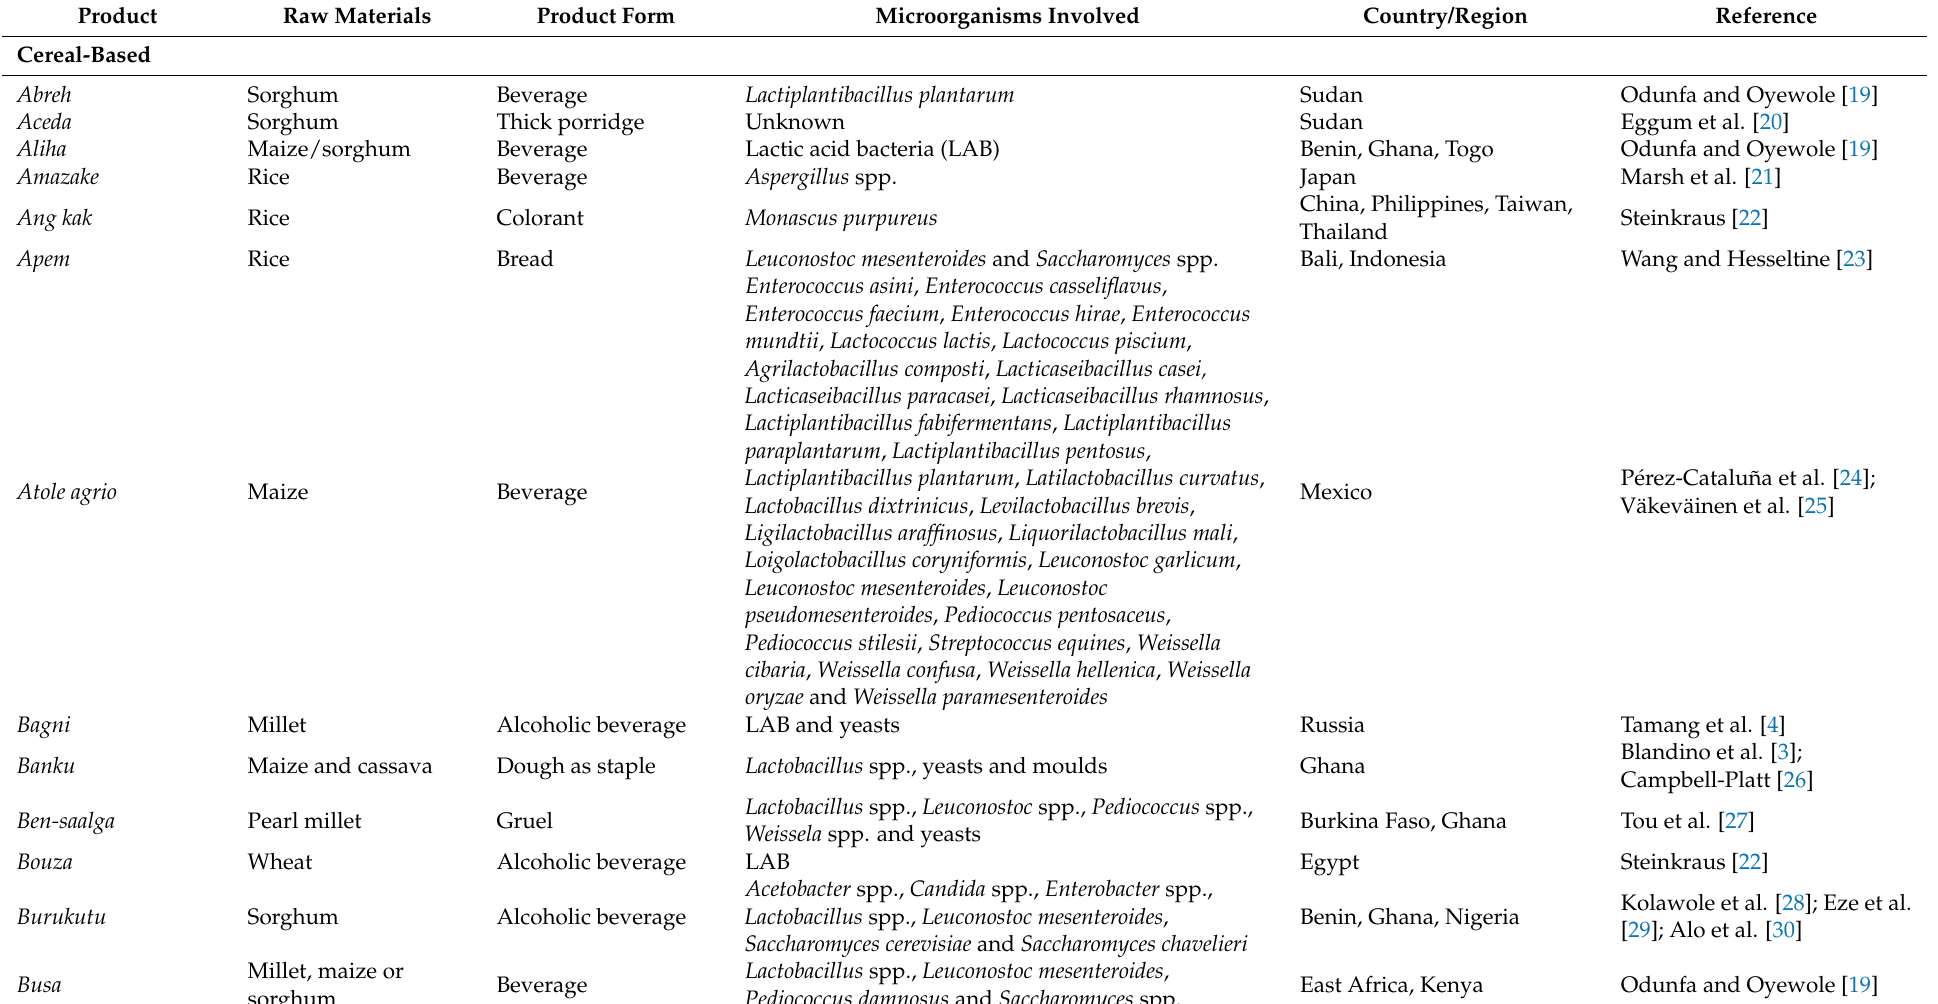
Table 1. Some cereal fermented products and associated microorganisms responsible for